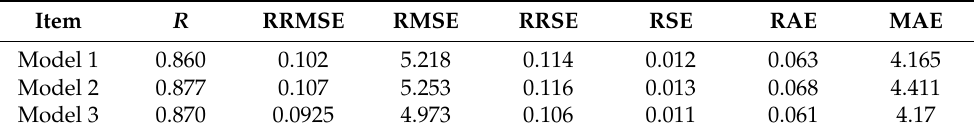
Table 5. Statistical validation methods for the compressive strength of all